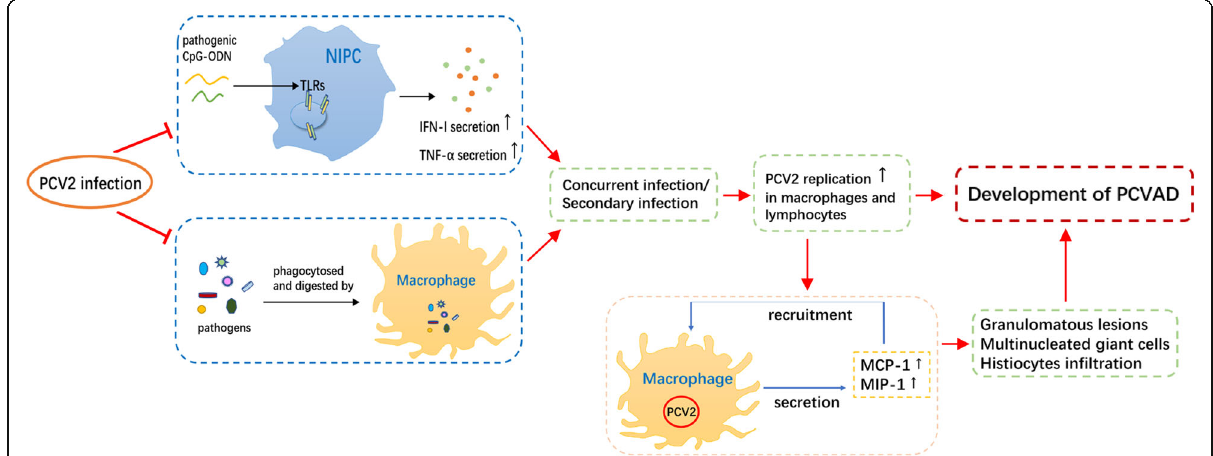
Fig. 1 Speculated involvement of natural interferon producing cells (NIPCs) and monocytes/macrophages in the pathogenesis of PCVAD induced by co-infection with PCV2 and other pathogens. PCV2 DNA has been reported to interfere with the response of NIPCs to pathogenic cytosine- phosphorothioate-guanine-oligodeoxynucleotides (CpG-ODNs) and hence suppress the production of IFN- α and TNF- α . On the other hand, PCV2 infection impairs the phagocytic and microbicidal ability of macrophages. These findings indicate that interactions of PCV2 with NIPCs and macrophages render host more susceptible to concurrent or secondary infection. Considering that the replication of PCV2 in macrophages is proposed to be achievable in vitro using appropriate stimulatory signals (such as the liposaccharide signal) and that it leads to the accumulation of the viral antigen, it can be speculated that immune stimulation by infection or vaccination promotes PCV2 replication in lymphoid tissues, which may provide a good explanation of PCVAD development following co-infection of PCV2 with other viral or bacterial pathogens rather than by PCV2 infection alone. In addition, interaction of monocyte/macrophage cell lineages with PCV2 plays an important role in mediating granulomatous lesions in lymph nodes and inducing PCVAD. Macrophages are recognized to be the primary cell source of MCP-1 and MIP-1,